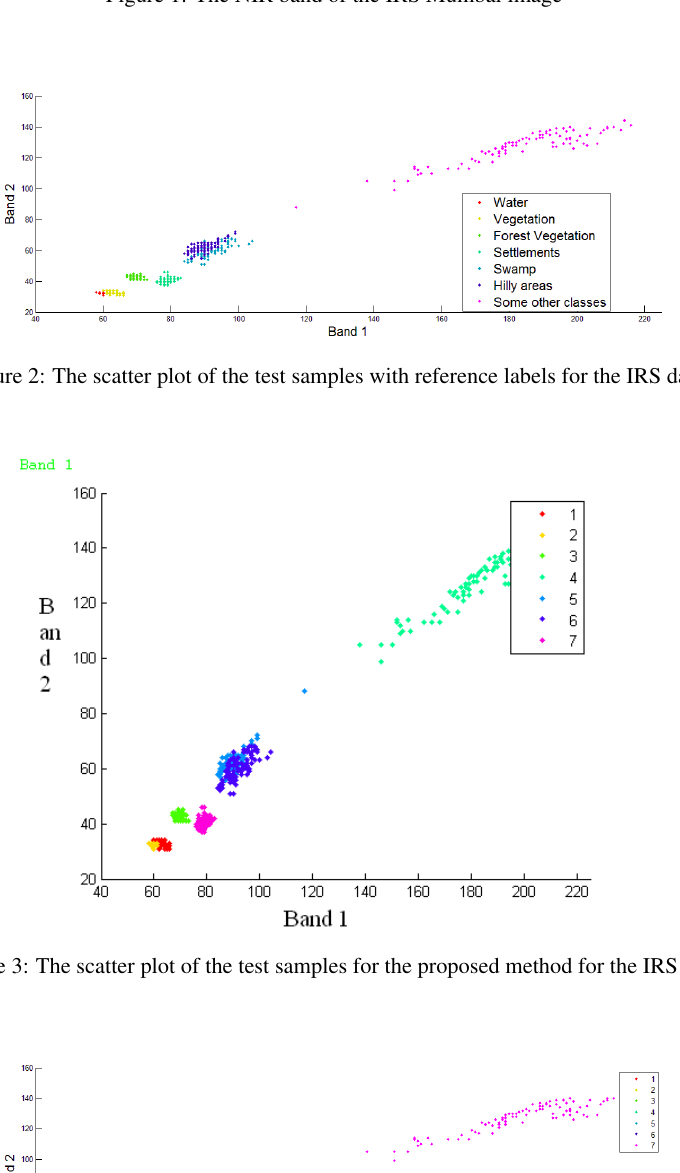
Figure 1: The NIR band of the IRS Mumbai image